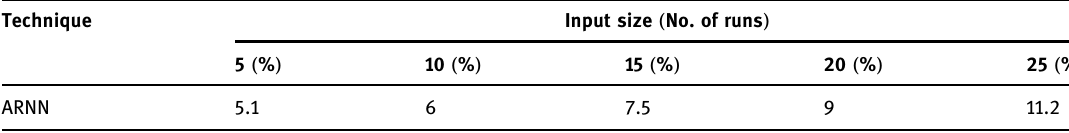
Table 4: Computational complexity of ARNN model